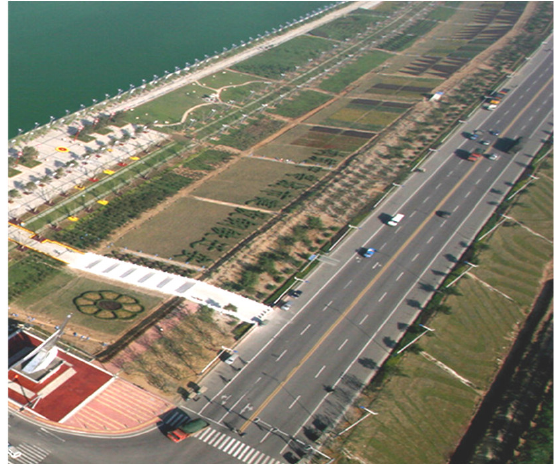
Figure 10. Green dikes adopting ecological slope protection materials.